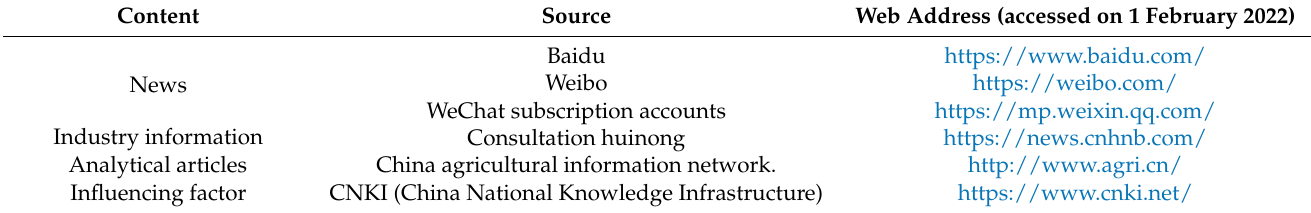
Table 1. Text Data